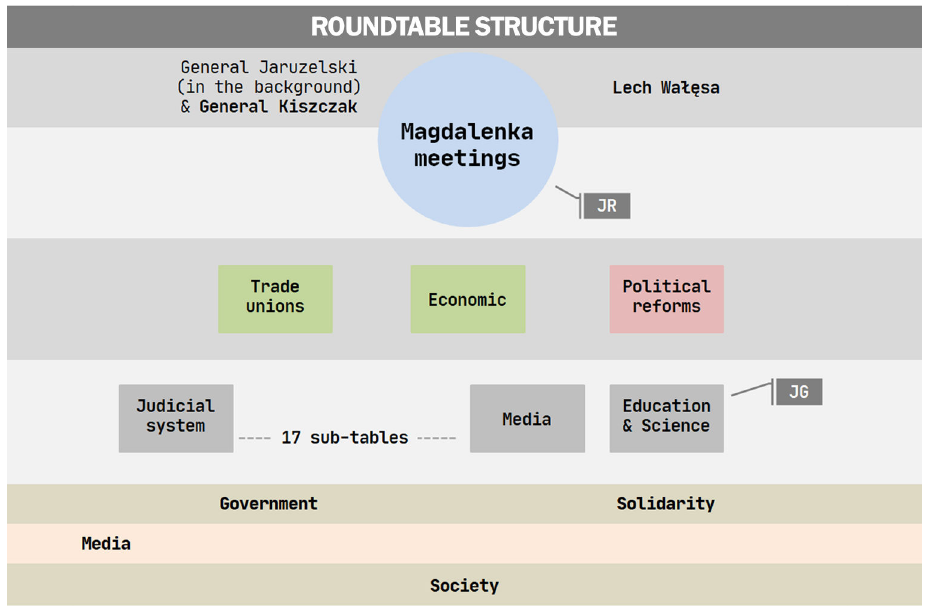
Figure 1. The structure of the Round Table Talks. JR = J. Reykowski; JG = J.